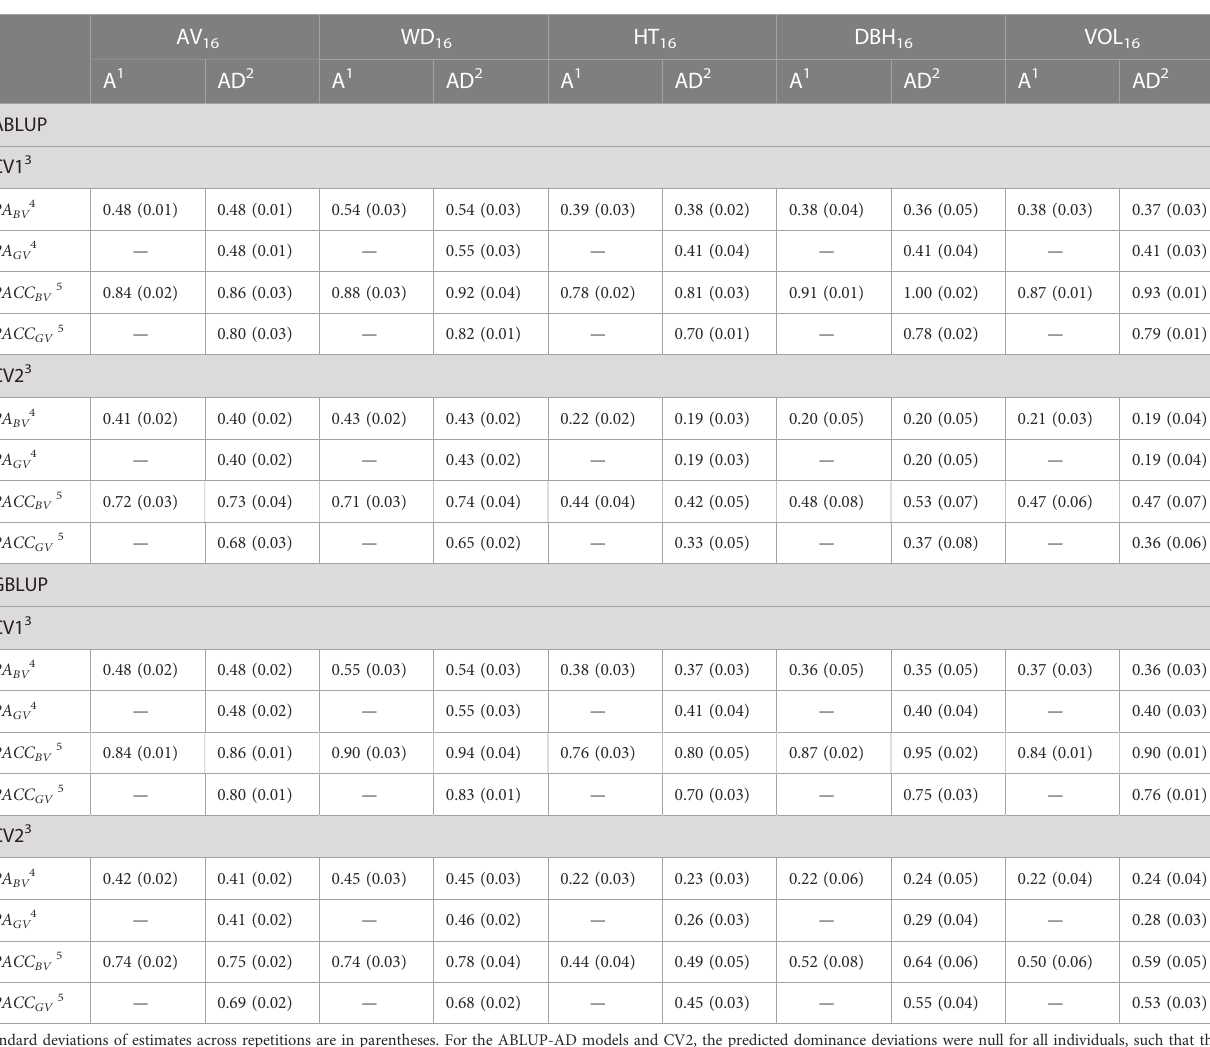
TABLE 4 For the complete dataset 1, average across-site predictive ability ( PA ) and prediction accuracy ( PACC ) obtained from cross-validation using the ABLUP and GBLUP additive (A) and additive-dominance (AD)